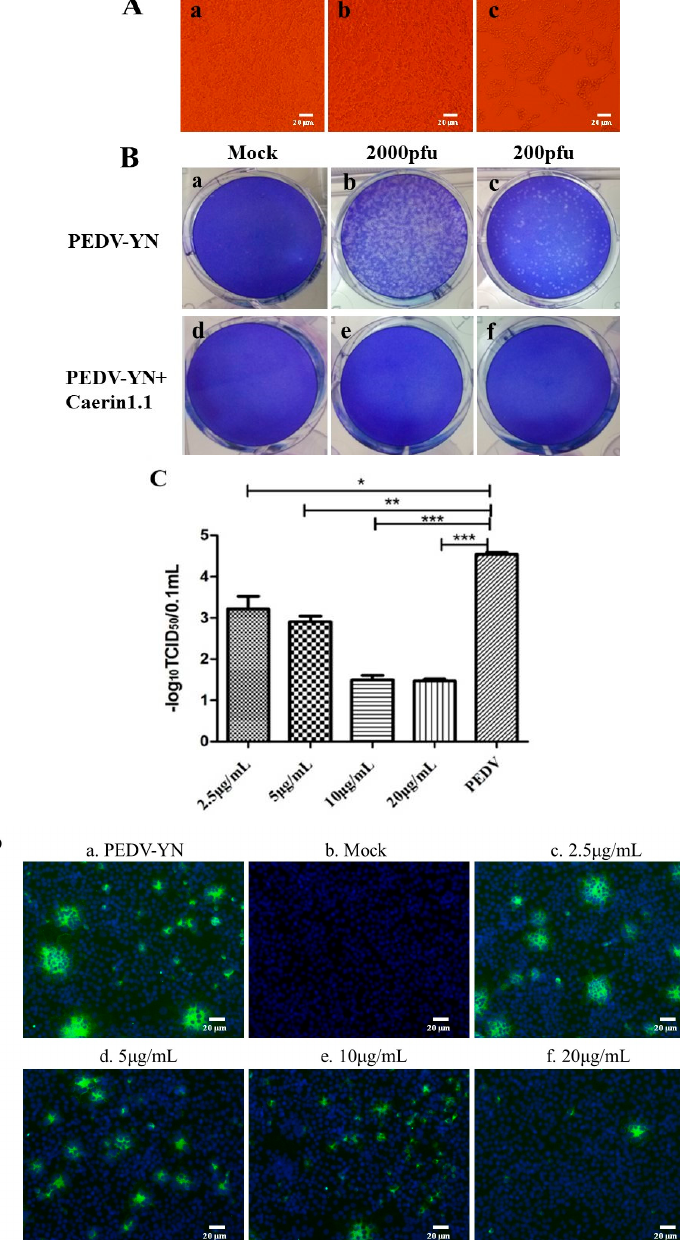
Figure 3. The inhibitory effect of Caerin1.1 against porcine epidemic diarrhea virus (PEDV)-YN strain. ( A ) (a) mock-infected cells, PEDV-infected Vero cell morphology in the presence (10 µ g/mL) (b) or absence (c) of Caerin1.1; ( B ) The number of plaques (clear spots) observed represents the number of viruses in a given dilution (a) Mock-infected cells; Cells infected with PEDV titer of 2000 pfu (b) and 200 pfu (c); (d) cells treated with 10 µ g/mL Caerin1.1; Cells infected with PEDV titer of 2000 pfu (e) and 200 pfu (f) in the presence of Caerin1.1 (10 µ g/mL); ( C ) The titer of PEDV was detected under the treatment of different concentration of Caerin1.1 (2.5, 5, 10, 20 µ g/mL) after one hour. The control groups (PEDV) were not treated by Caerin1.1. The results of three independent experiments are presented as the mean ± SD. The statistical analysis was performed using Graph Pad Prism5.0. The significance was defined as p < 0.05 (*), and the higher significance was defined as p < 0.01(**), p < 0.001(***); ( D ) Fluorescence intensity of PEDV in the presence of Caerin1.1 at different concentration. (a) Cells infected with PEDV of 200 pfu; (b) Mock-infected cells; PEDV were incubated with Caerin1.1 of 2.5 (c), 5 (d), 10 (e) and 20 (f) µ g/mL for 1 h. Scale bar, 20 µ